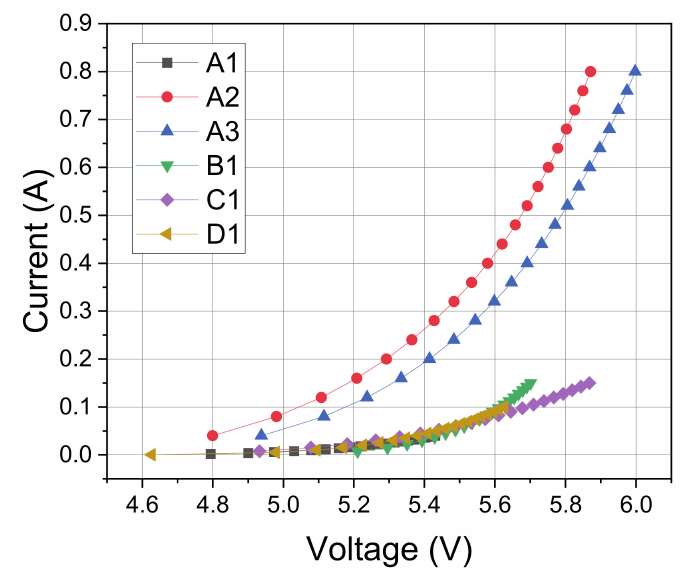
Figure 4. Electrical characteristics of the selected LEDs.